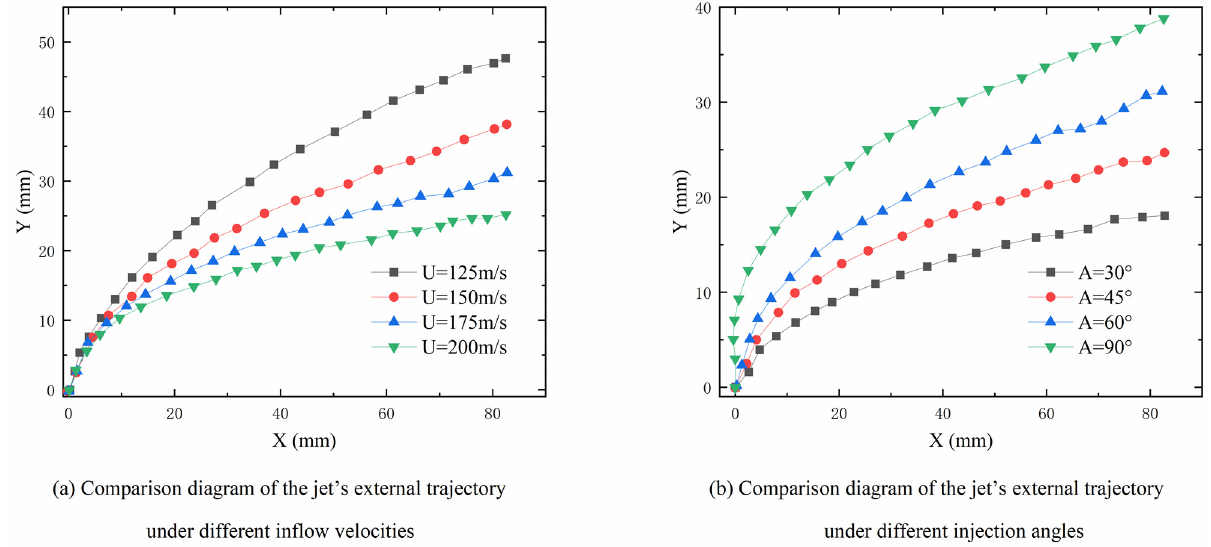
Figure 8. Comparison diagram of the jet’s external trajectory under different inflow velocities and injection angles.